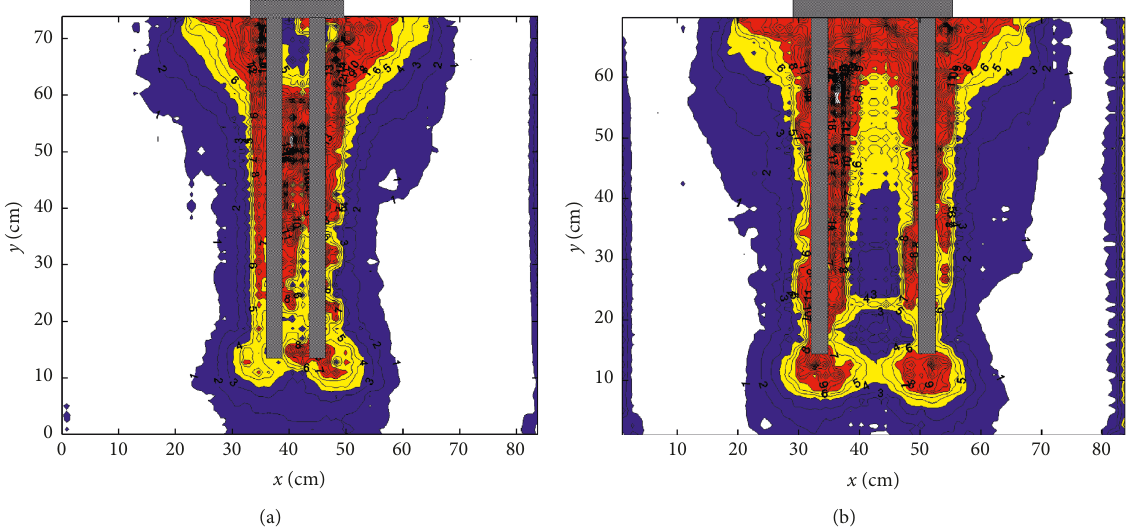
Figure 11: Contours of the maximum shear strain around the pile groups. (a) 3 b pile spacing. (b) 6 b pile